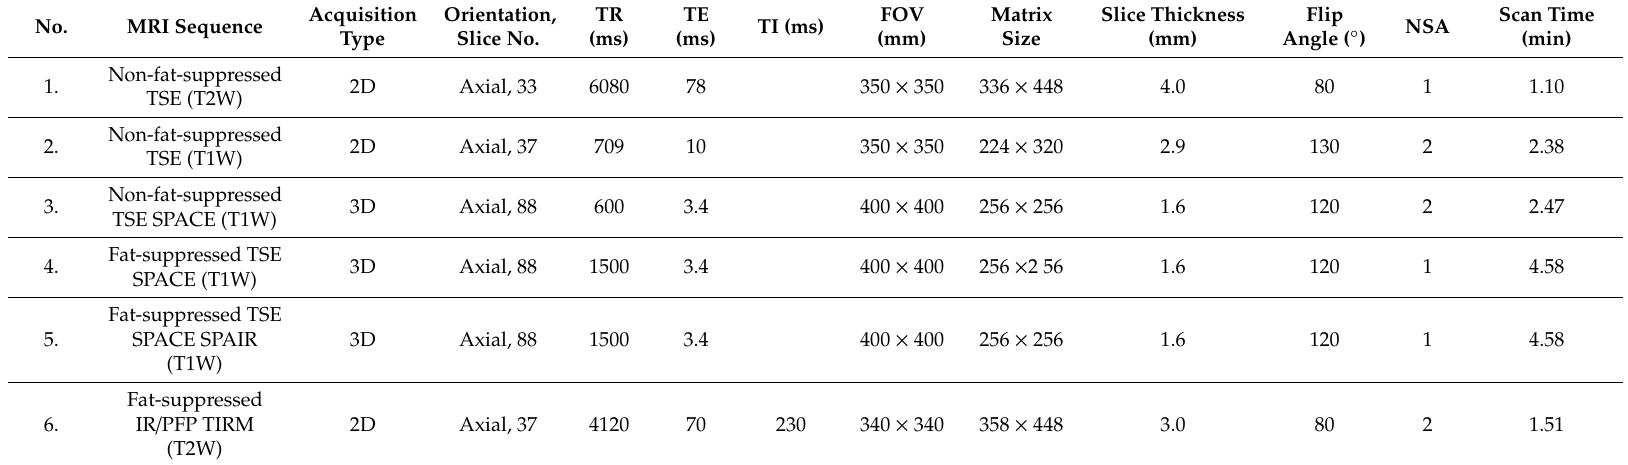
Table 1. Image acquisition parameters of the MR breast-imaging sequences using a personalized 3D-printed breast